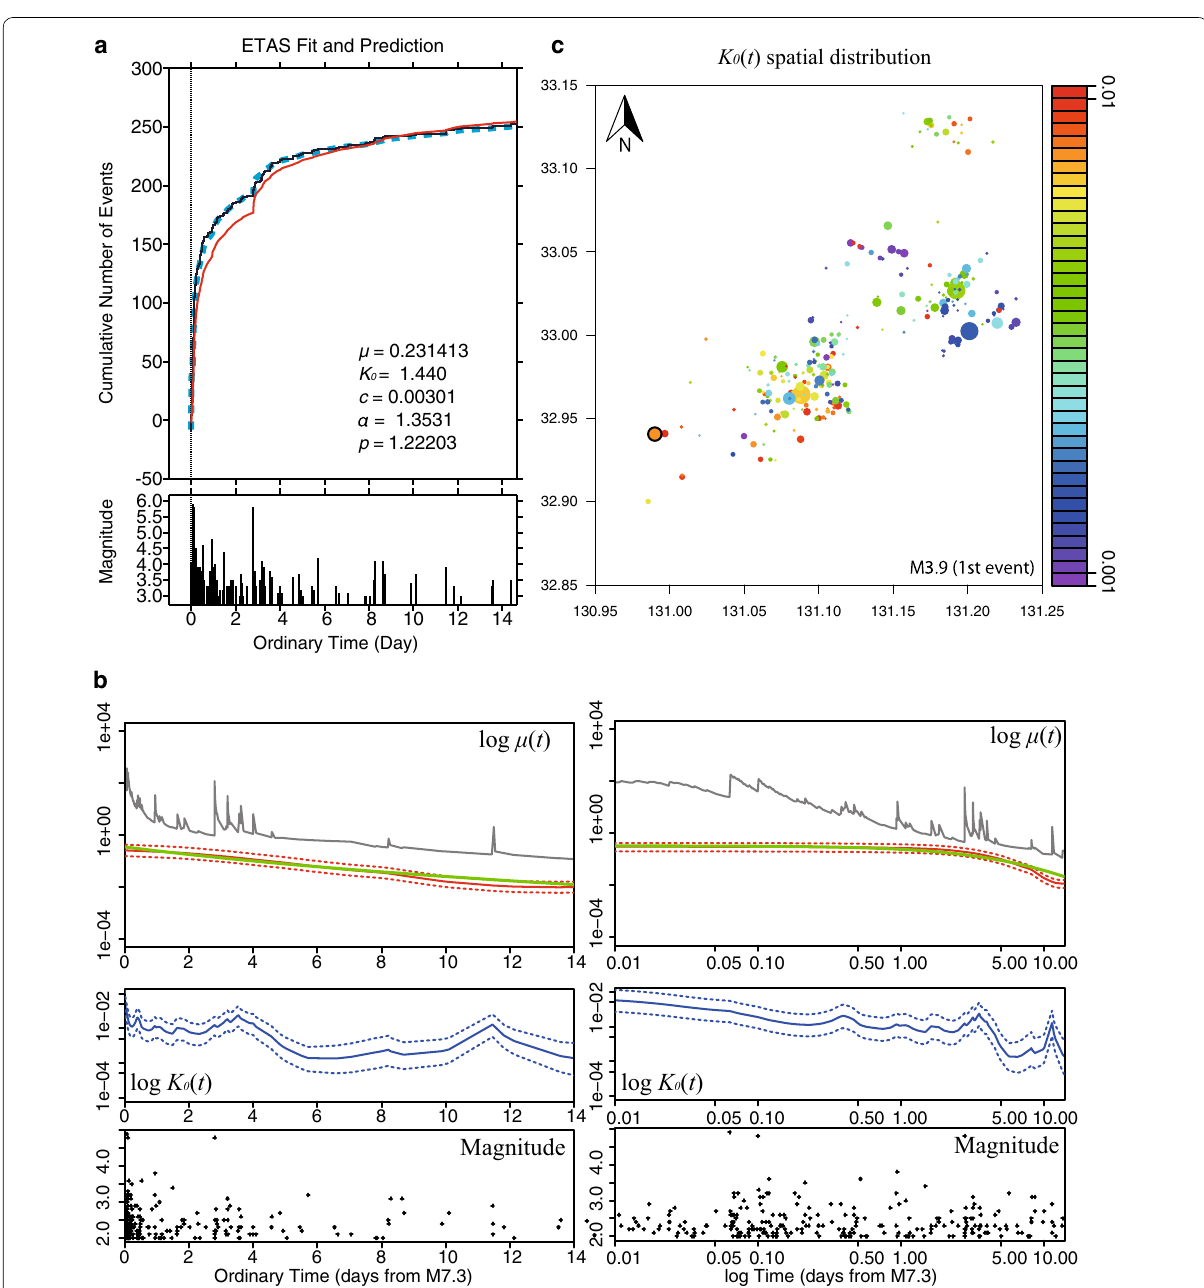
The differences in the AIC value of the two-stage ETAS model and ABIC value of the non-stationary ETAS model from the AIC of the reference ETAS model are listed. The AIC of the baseline ETAS model is the same as the ABIC of the reference ETAS model. These values are estimated for the entire period for the target region; T c corresponds to the natural change-point at the occurrence time of the M7.3 mainshock, and days are counted from the occurrence time of the M6.5 foreshock event